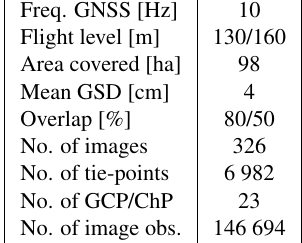
Table 2. Summary of aquired data.